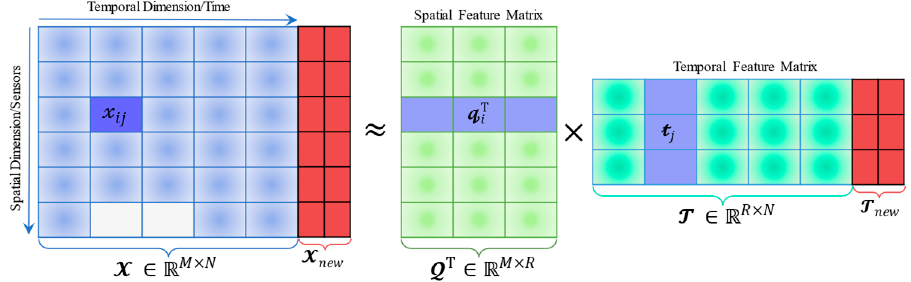
Figure 2. Schematic of the spatial-temporal matrix factorization (white boxes denote missing data).